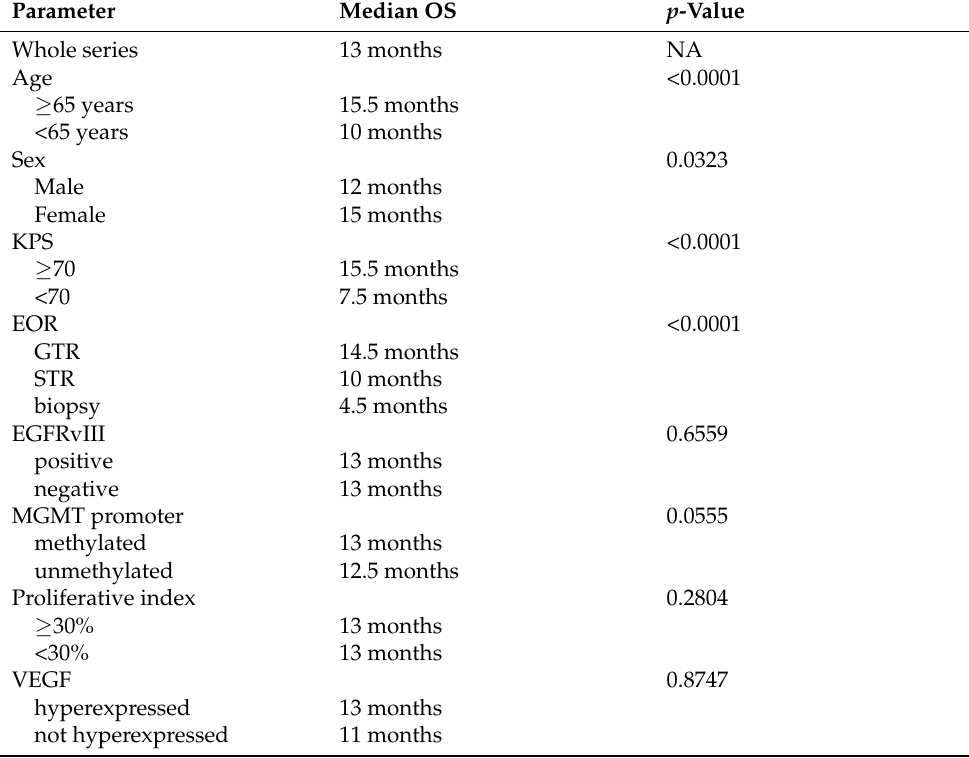
Table 3. Univariate analysis for survival.